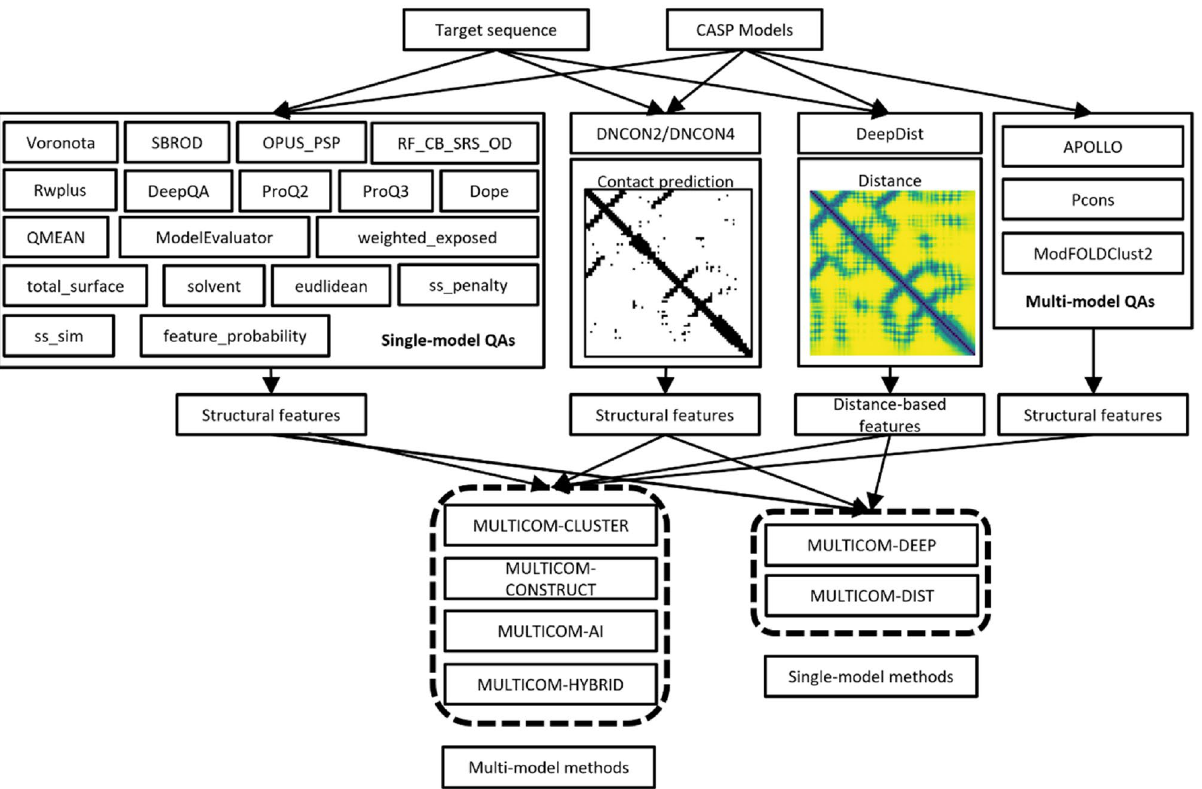
Figure 1. The pipeline of MULTICOM EMA predictors. Multi-model methods (MULTICOM-CLUSTER/ CONSTRUCT/AI/HYBRID) uses both single-model quality assessment features and multi-model